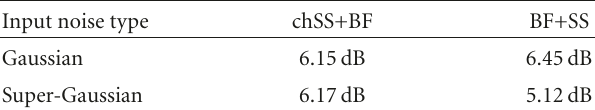
Table 1: Speech distortion comparison of chSS+BF and BF+SS on the basis of CD for four-microphone